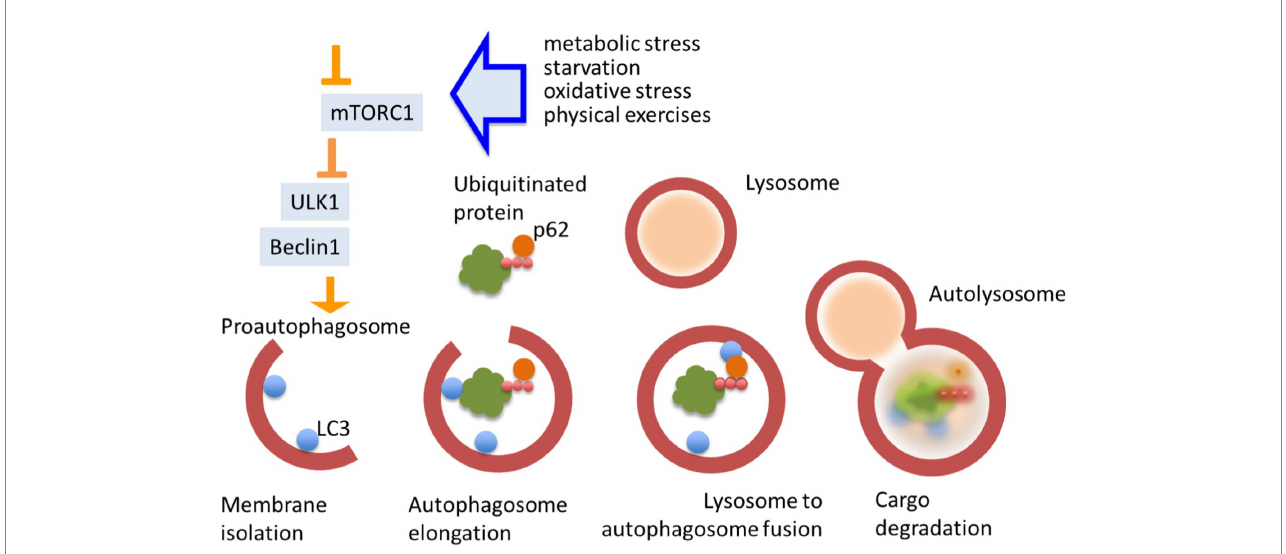
FIGURE 1 Autophagy flux. Autophagy is a pivotal mechanism of cellular homeostasis. It is triggered by chemical stress and its flux is regulated by multiple cellular signaling pathways. Autophagy strongly depends on the activity of mTORC1. Unc-51 like autophagy activating kinase (ULK1) and Becline1 are essential initiators of autophagosome formation. Cargo specificity is conferred by autophagic receptors that recognize specific target (proteins and other macromolecules), linked to p62, for degradation and microtubule-associated protein 1A/1B-light chain 3 LC3. Autolysosomes are docked to cellular membranes with subsequent devastation and release of